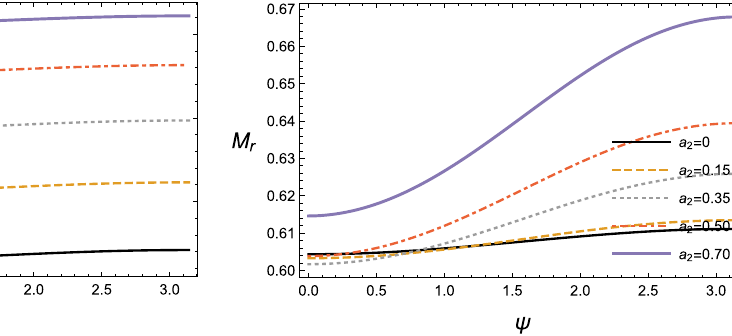
(b) The bounds for ψ at the different a 2 under ρ = 1, g = 0 . 5, M 1 = 1, a 1 = 0 . 35, and M 2 = 1.